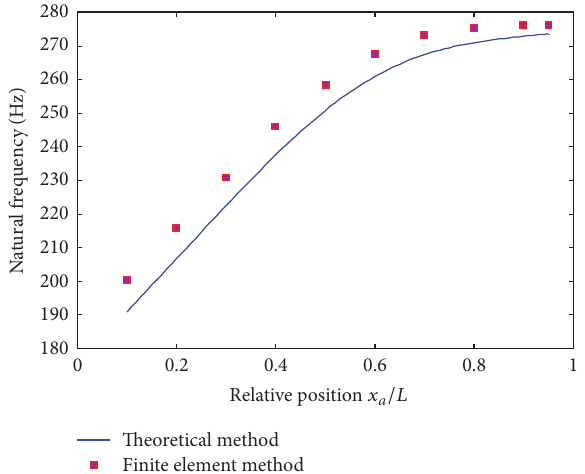
Figure 13: Natural frequencies of the oblique crack for different